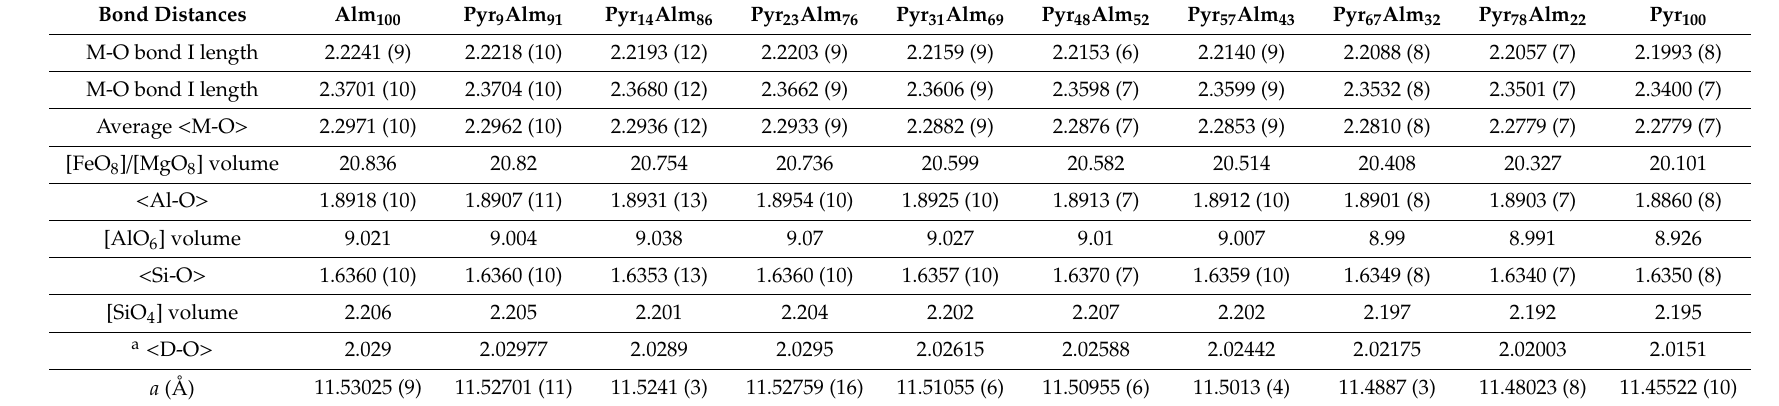
Table 3. Selected bond distances (Å) for almandine-pyrope garnet samples in this